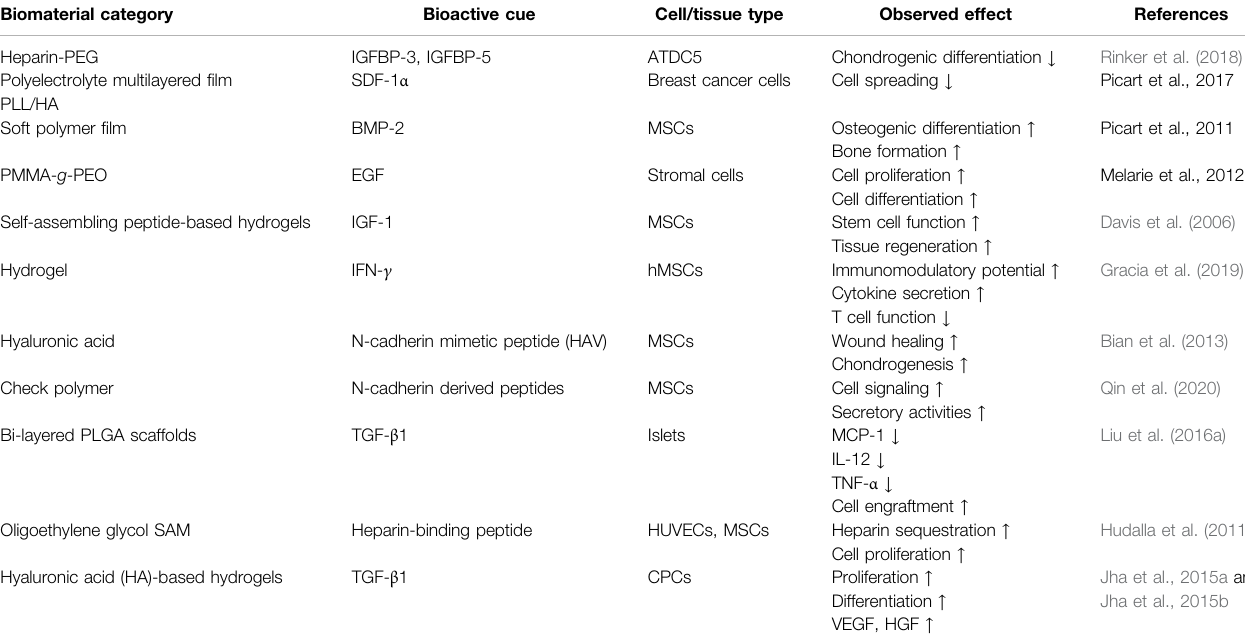
TABLE 2 | Enhancing stem cell function using matrix-anchored bioactive